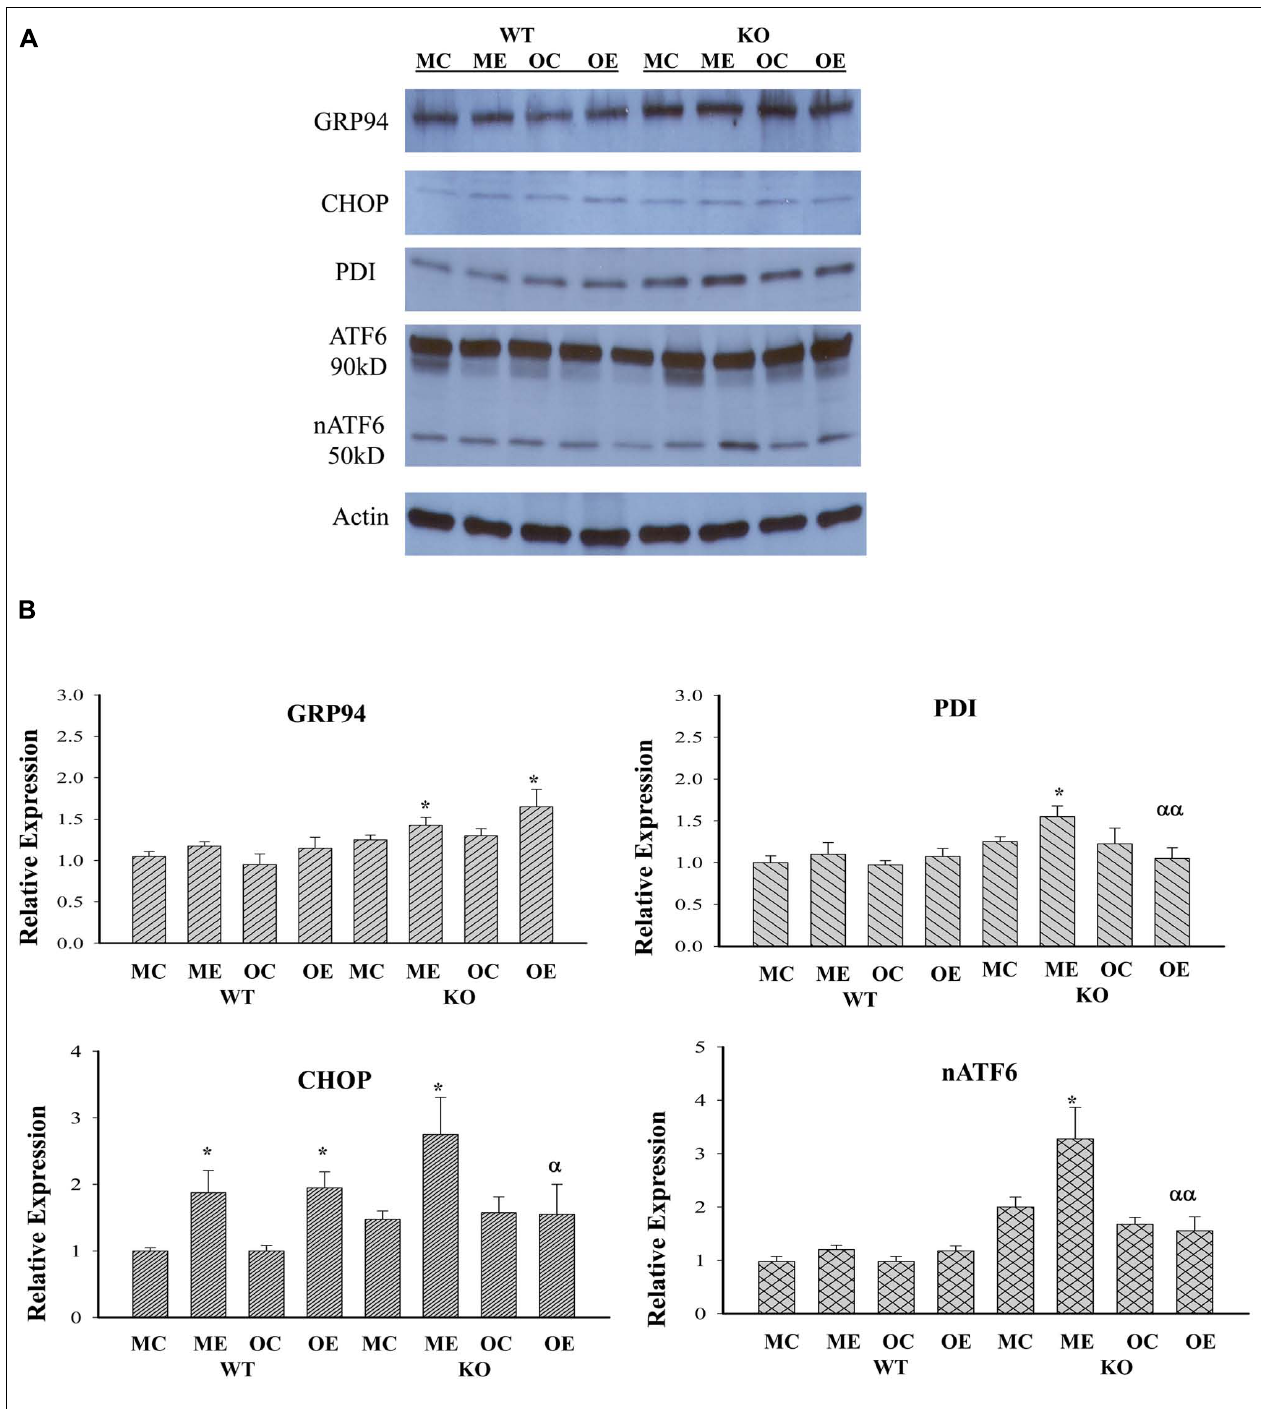
FIGURE 4 | Immunoblotting analysis of liver proteins of ER stress markers from alcohol-fed mice. KO, liver-specific knockout of immunoglobulin heavy chain-binding protein (BiP), also known as glucose-regulated protein 78 (GRP78); WT, wild type littermate; GRP94, glucose-regulated protein 94; CHOP, DNA damage-inducible transcript 3, also known as C/EBP homologous protein; nATF6, activated form of the activating transcription factor 6; PDI, protein disulfide isomerase; MC,